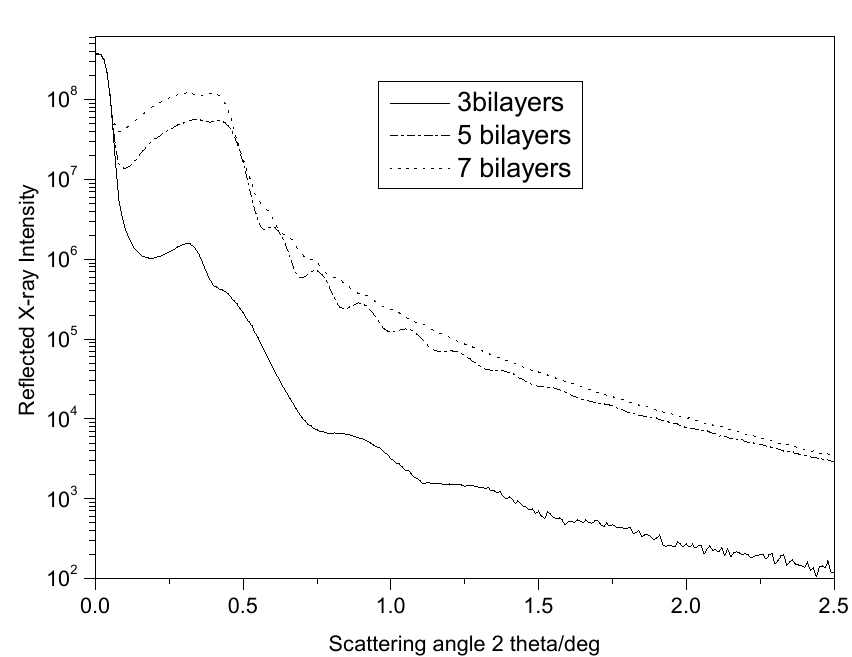
Figure 6. XRR patterns of the deposited bilayers on silanized silicon